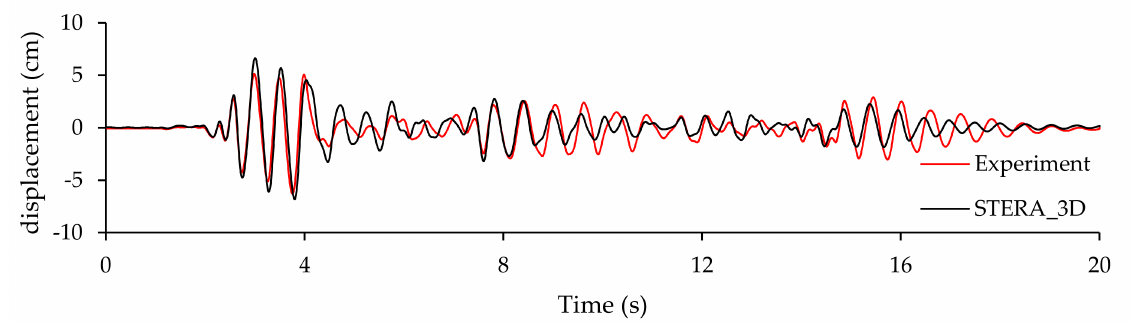
Figure 12. Roof displacement history responses of experiment of stepped setback structure compared with